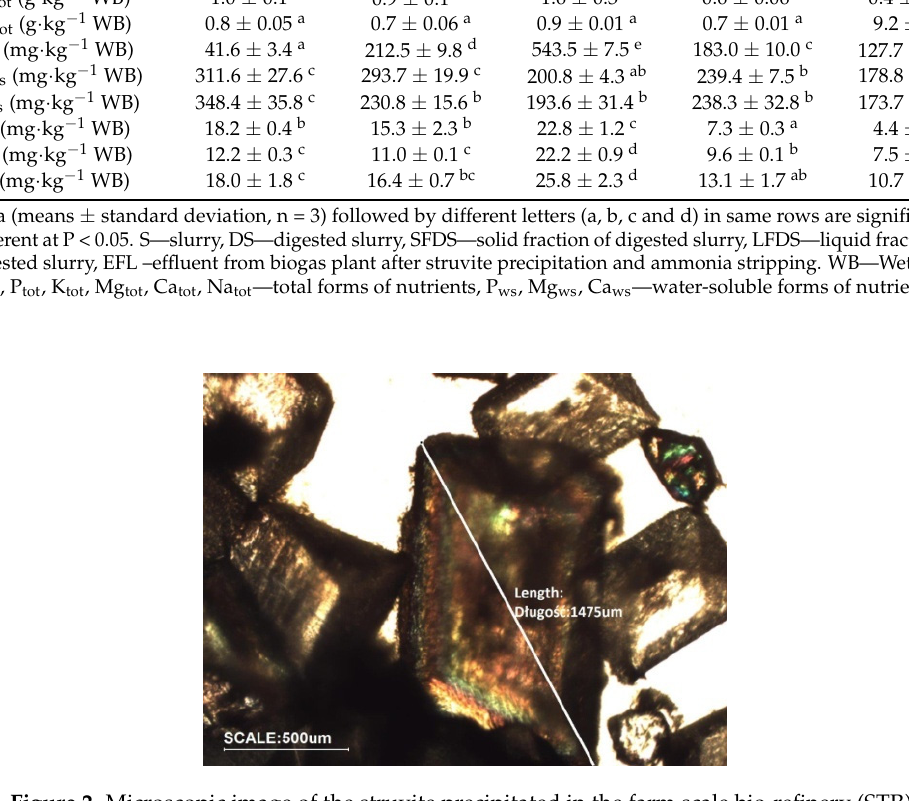
Figure 2. Microscopic image of the struvite precipitated in the farm scale bio-refinery (STR).